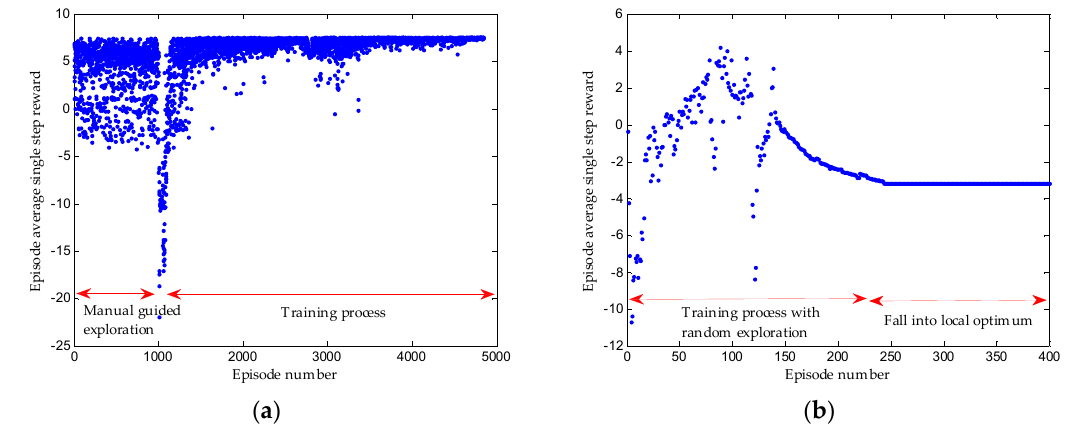
Figure 12. ( a ) Training process by manual guided exploration. ( b ) Training process by random exploration.